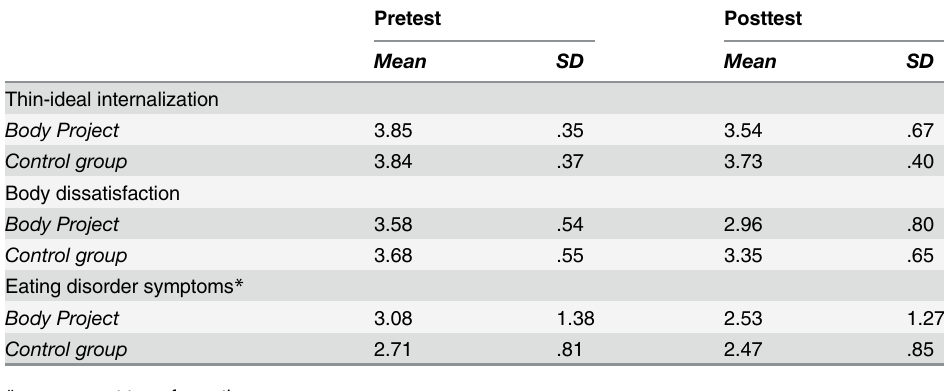
Table 1. Means (SD) for Outcomes in the Body Project and Control Conditions.